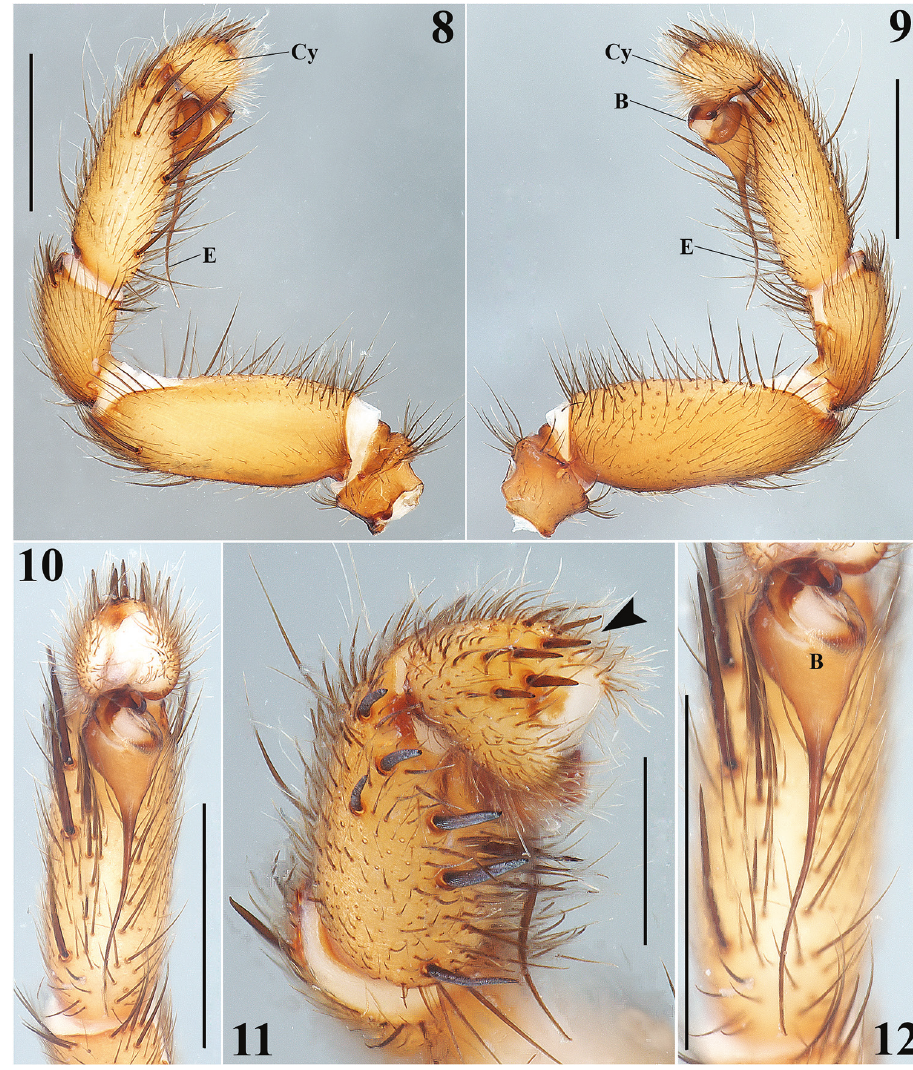
Figures 8–12. Aptostichus sabinae sp. n. Male holotype: 8–9 Left palp, prolateral and retrolateral views respectively 10 Left palp, ventral view 11 Left palp, prolateral-apical view (arrow indicates apical spines on cymbium) 12 Detail of the bulb and embolus, ventral view. Scale bars 0.5 mm ( 11 ), 1 mm ( 8–10 , 12 ). scopulae on all legs (Fig. 16). Tibiae, metatarsi and tarsi with trichobothria: Tibiae I-IV: two prolateral-dorsal rows with 9 trichobothria each, distal ones becoming larger; metatarsi I and II: one dorsal row with 12; metatarsi III: one dorsal row with 15; metatarsi IV: one dorsal row with 19; tarsi I: slightly staggered dorsal row with 10; tarsi II: slightly staggered dorsal row with 12; tarsi III: slightly staggered dorsal row with 10; tarsi IV: slightly staggered dorsal row with 11. Legs spination pattern: